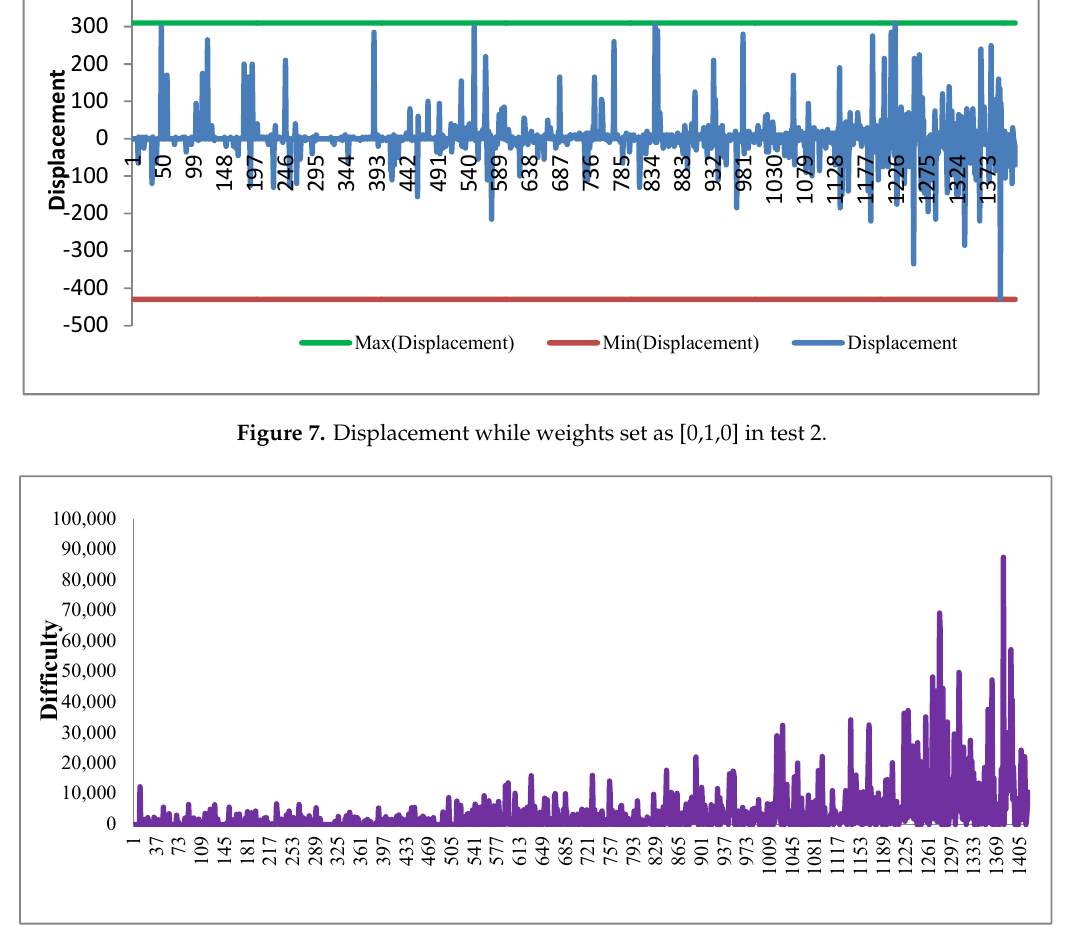
Figure 8. Difficulty of every slot allocation while weights set as [0,1,0] in test 2.